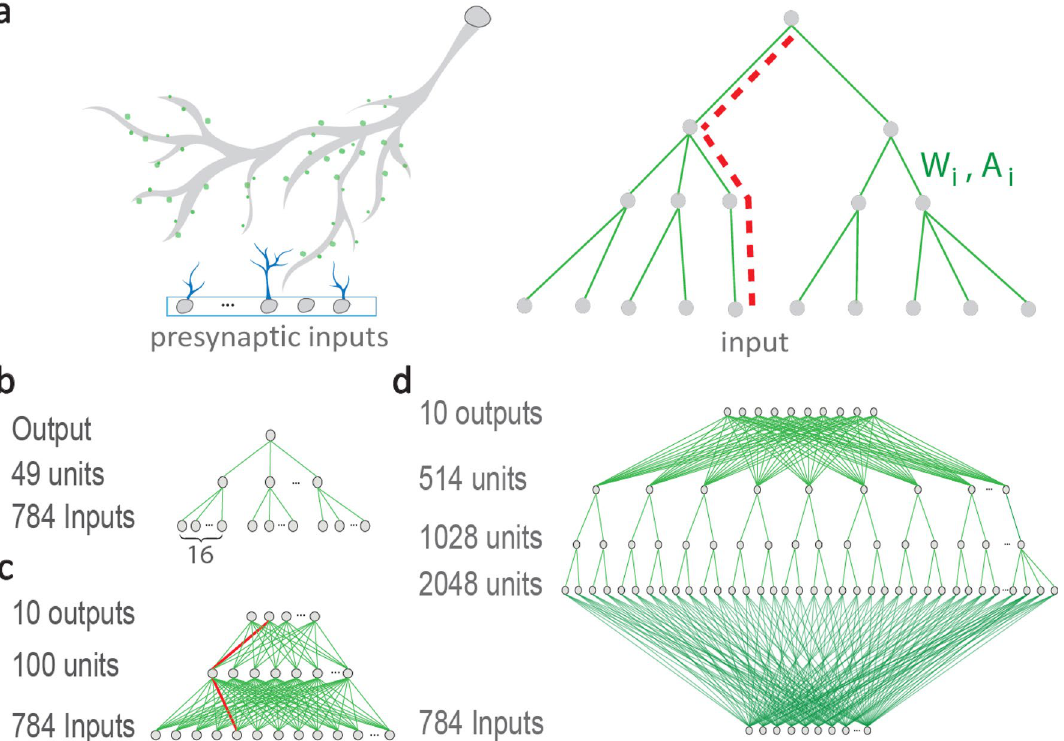
Figure 2. From dendritic learning to BP on FFTNs. ( a ) Neuronal scheme of a dendritic tree (left), synapses (green circles), and their presynaptic input neurons (bottom gray circles) and axons (blue). Similar tree scheme (right) with a single route (red dashed line) from the output to each input. Each tree segment is characterized by weight W i and nonlinear amplification A i . ( b ) Trained FFTN to recognize one handwritten digit. ( c ) Fully connected FFTN with 10 output units, one for each handwritten digit. ( d ) An example of FFTN with respect to weights, where each weight is connected to an output unit via one route